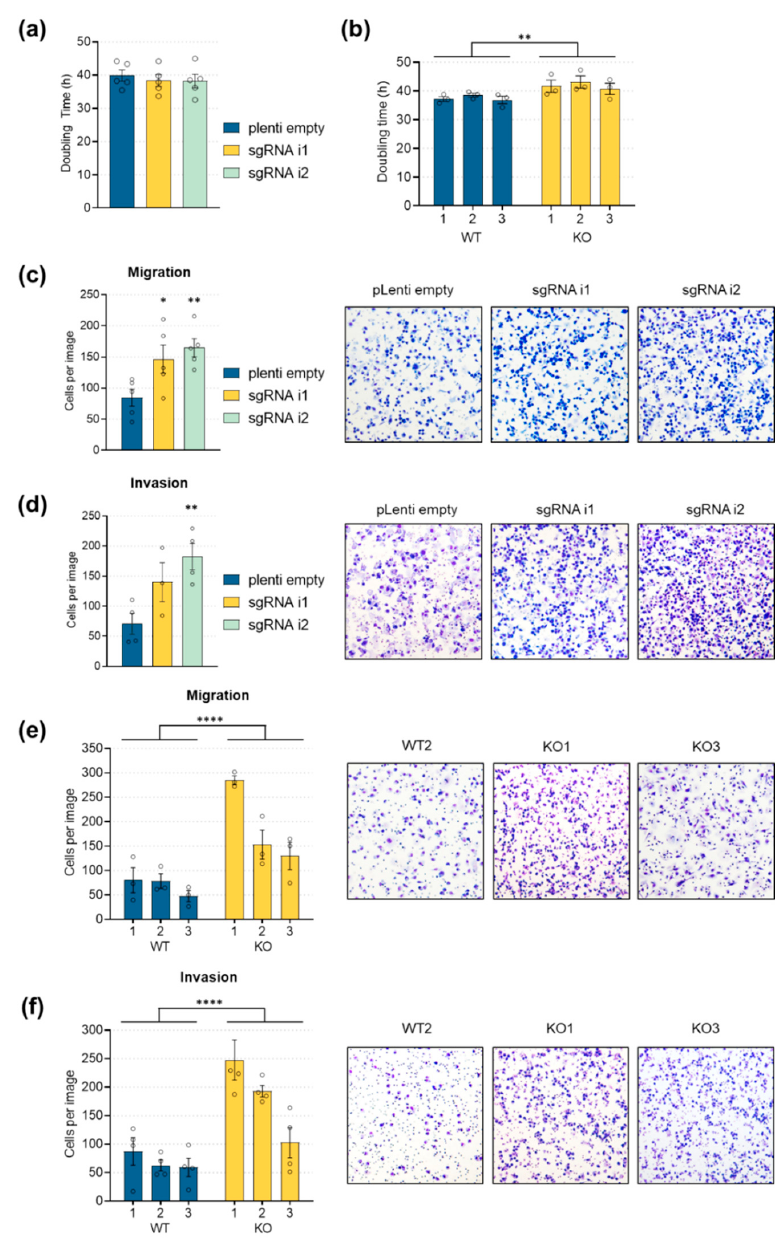
Figure 7. Enhanced cell migration and invasion in LINC00261 low cells. ( a,b ) Cell doubling time in PANC-1 cells after CRISPRi-mediated LINC00261 downregulation and in three wild-type and three LINC00261 promoter knockout cell clones (** p < 0.01, one-way (a) and two-way ANOVA (b)). ( c,d ) Transwell migration (c) and invasion (d) assays in PANC-1 cells after CRISPRi-mediated LINC00261 downregulation (* p < 0.05, ** p < 0.01, one-way ANOVA). ( e,f ) Transwell migration (e) and invasion (f) assays in PANC-1 cells after CRISPR/Cas9-mediated knockout of LINC00261 promoter. Quantification of migrated and invaded cells (c–f) from five random fields of three wild-type and three knockout clones after eosin Y and methylene blue staining using light microscopy (**** p < 0.0001, two-way ANOVA).